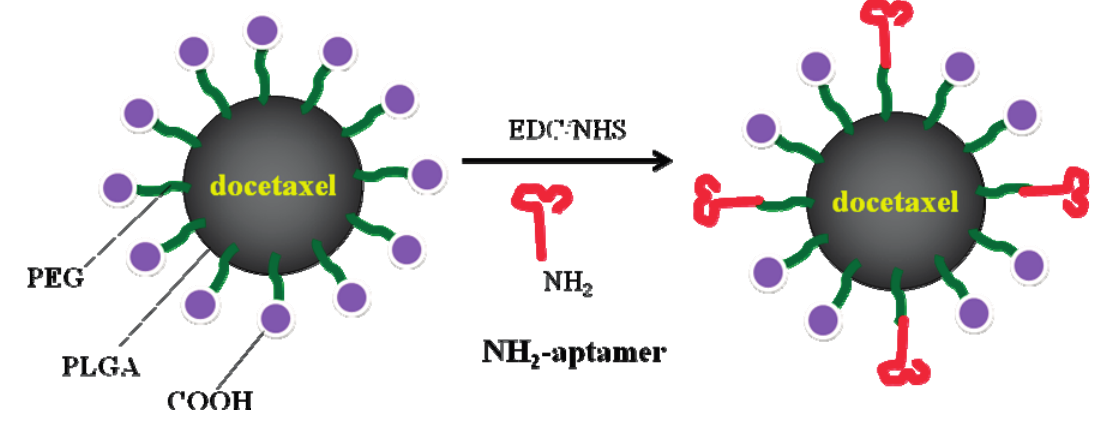
Scheme 6. Schematic representation of the synthesis of PLGA-PEG-COOH copolymer and strategy of encapsulation of Dtxl. Adapted from Reference